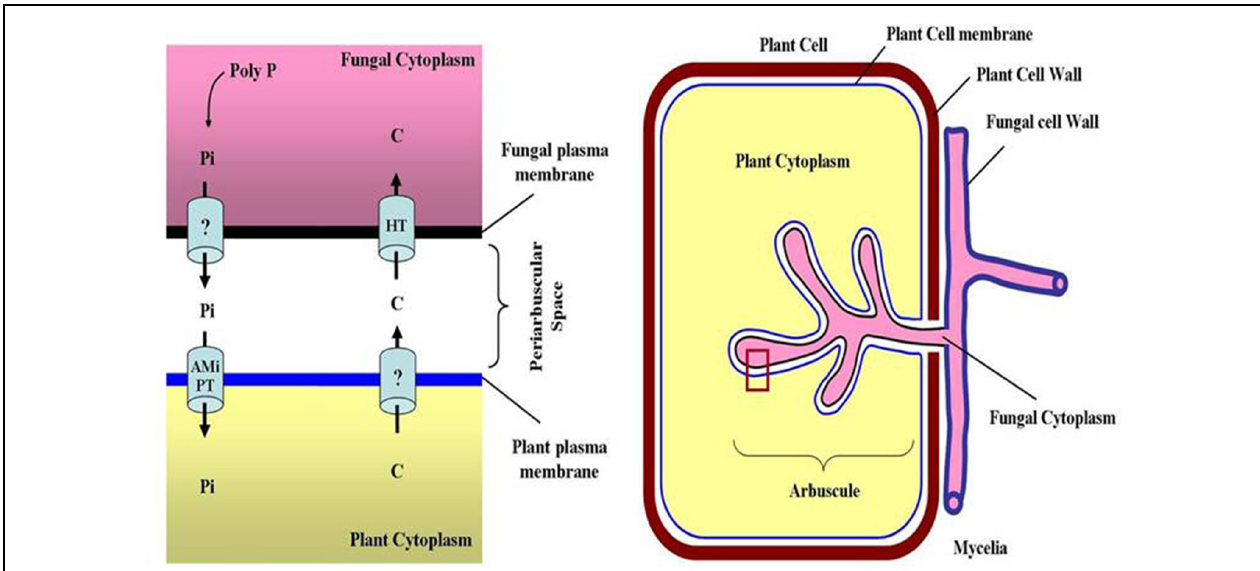
FIGURE 4 | Translocation of phosphorus (P) and carbon (C) at fungus – plant interface. Inorganic P is taken up by specialized transporters located on the fungal membrane in the extra-radical mycelium. Pi (originated in AM fungi from the hydrolysis of polyphosphate) is imported from the symbiotic interface to the plant cells through AM inducible Pi transporters (AMiPT). Hexose transporters (HT) import plant-derived carbon to the fungus, whereas transporter proteins involved in the export of nutrients from plant have not been identified yet.